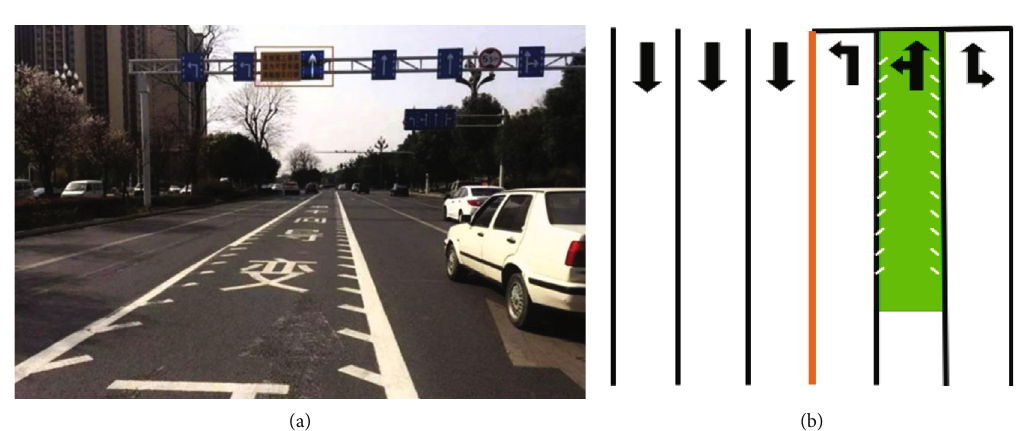
Figure 1: Reversible lane.